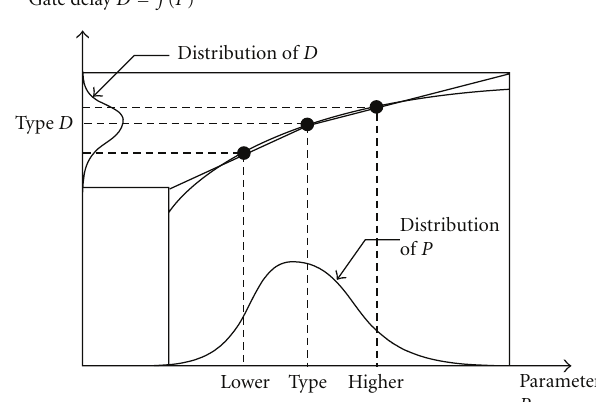
Figure 2: Calculating the delay distribution as a function of param- eter P